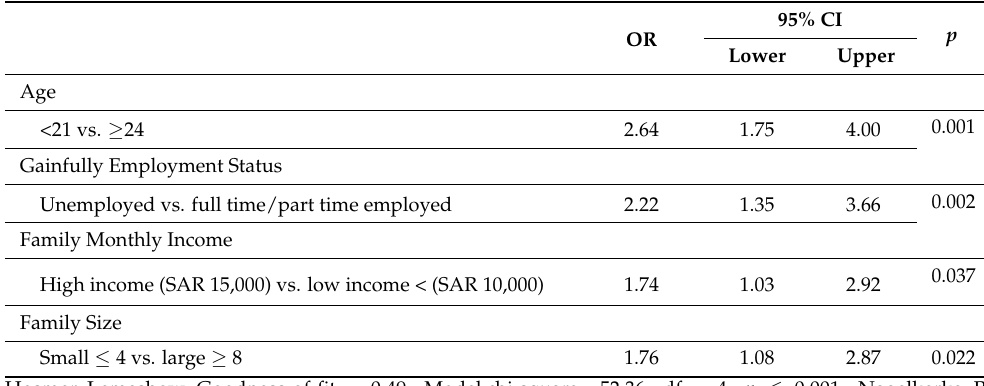
Table 5. Forward stepwise logistic regression analysis of associations of the sociodemographic variables with smartphone addiction, N =